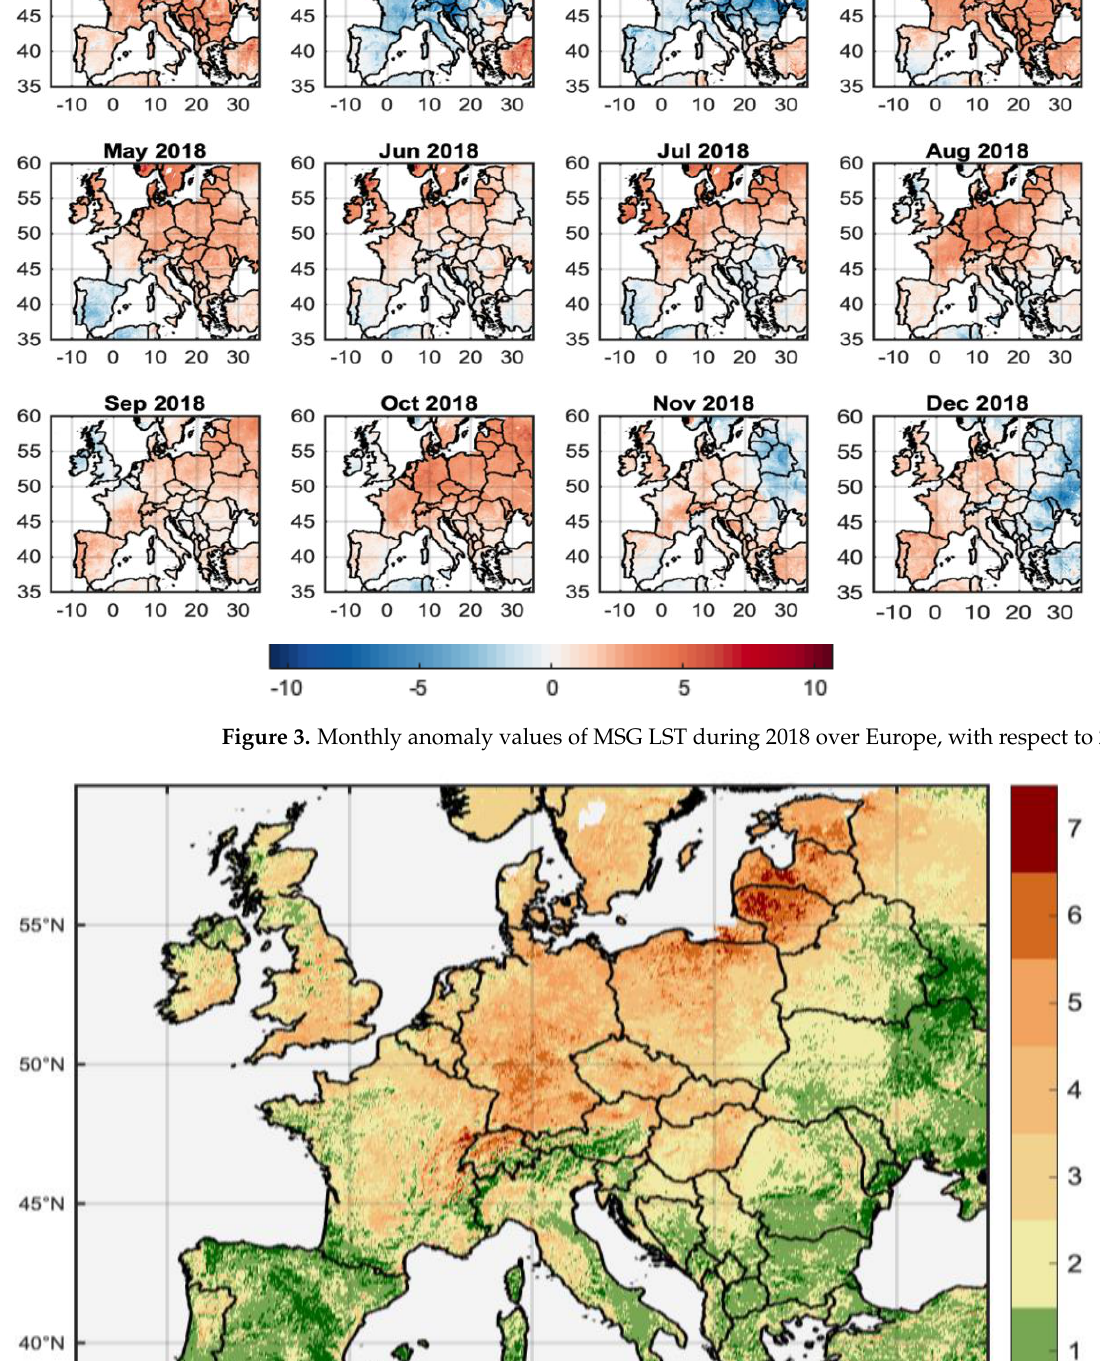
Figure 3. Monthly anomaly values of MSG LST during 2018 over Europe, with respect to 2004 – 2019.